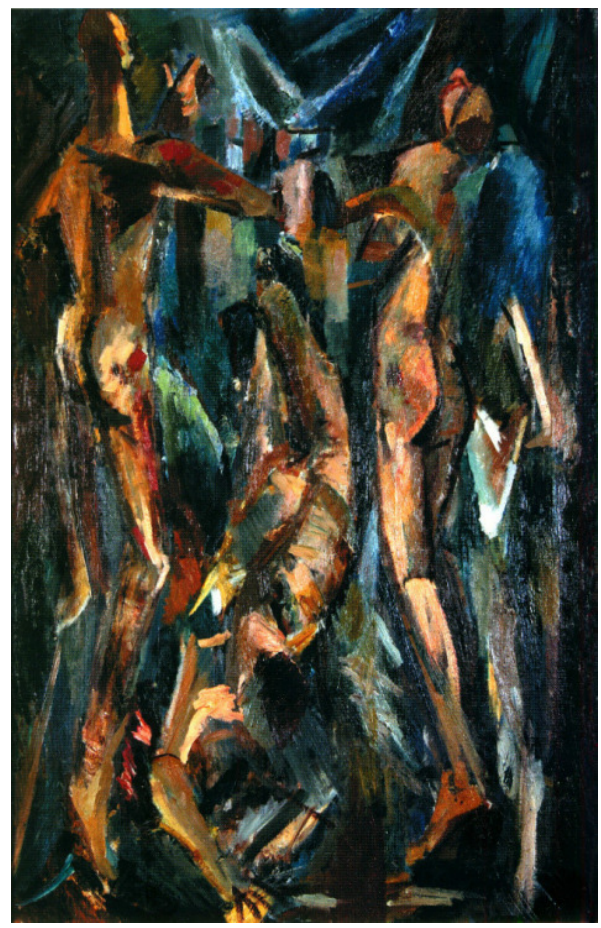
Figure 4. Vasily Chekrygin, Three Figures , 1914–1915, oil on canvas, Perm Picture Gallery.